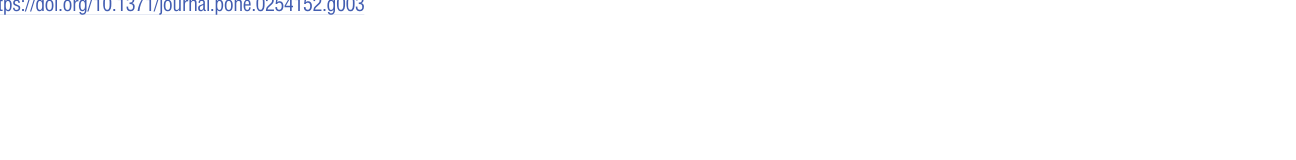
PLOS ONE | https://doi.org/10.1371/journal.pone.0254152 July 22,